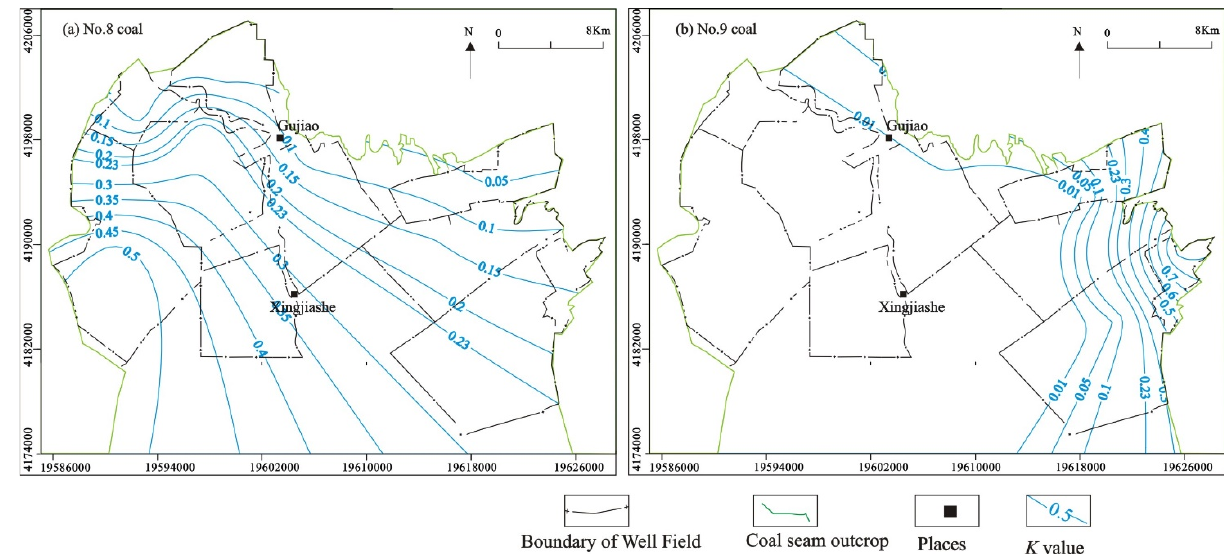
Figure 11. K value distribution of coal seams.